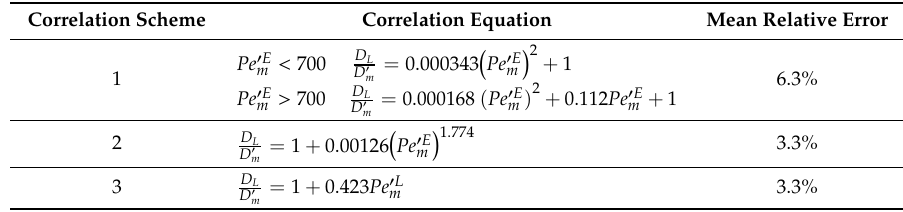
Table 4. Three correlation schemes for hydrodynamic dispersion of particle transport in an FCC- packed